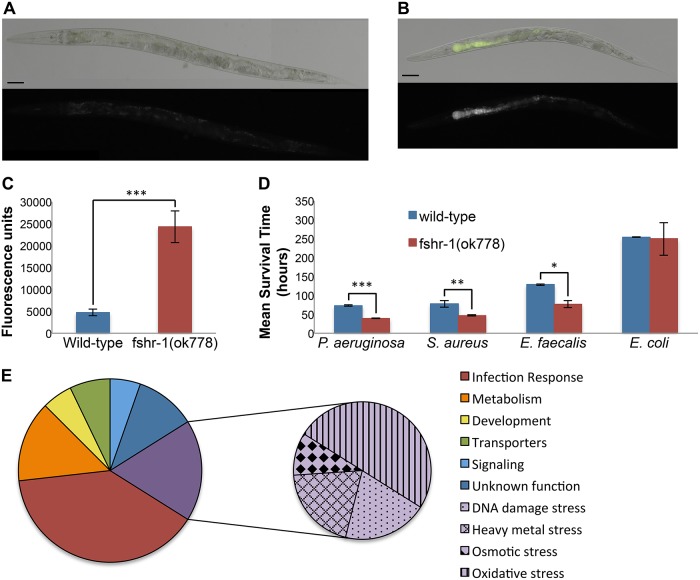
FSHR-1 is required for the defense against diverse pathogens.Representative wild-type (A) and fshr-1(ok778) mutant (B) worms fed GFP-PA14 for 18 hours. Scale bars = 100 μm. (C) Quantification of the sum of the intestinal fluorescence intensity for at least 10 representative individual worms per condition. (D) Mean survival time of wild-type and fshr-1(ok778) mutant worms exposed to different bacterial food sources. * P<0.05, **P<0.01, *** P<0.0001 in unpaired t-test. Error bars are SEM. (E) Functional annotation of genes whose mean expression from three microarray replicates in wild-type worms infected with PA14 for 4 hours was at least 2-fold higher than their mean expression in fshr-1(ok778) mutants infected with PA14 for 4 hours, with P<0.05. Genes known to be involved both in infection response and stress response were grouped with stress response.